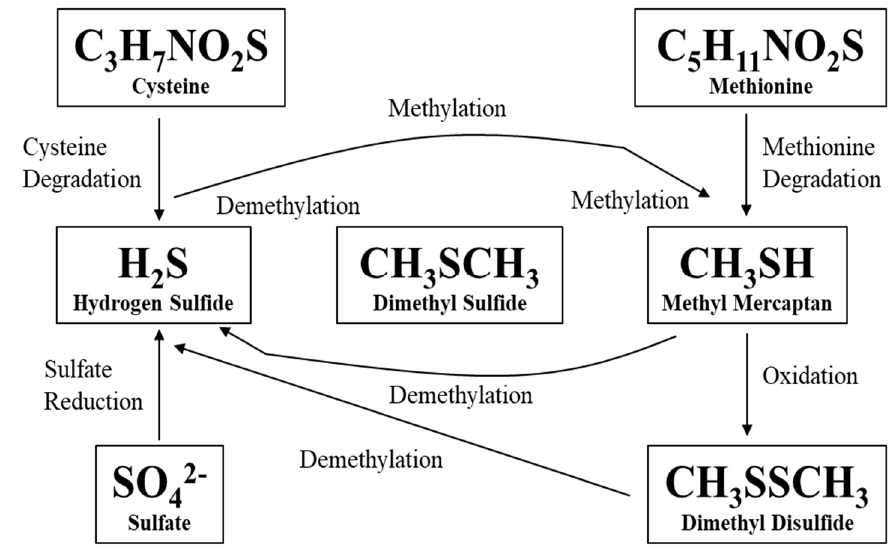
Figure 4. Production of odorous volatile sulfur compounds in a landfill. Based upon studies of anaerobically digested biosolids during cake storage [12].